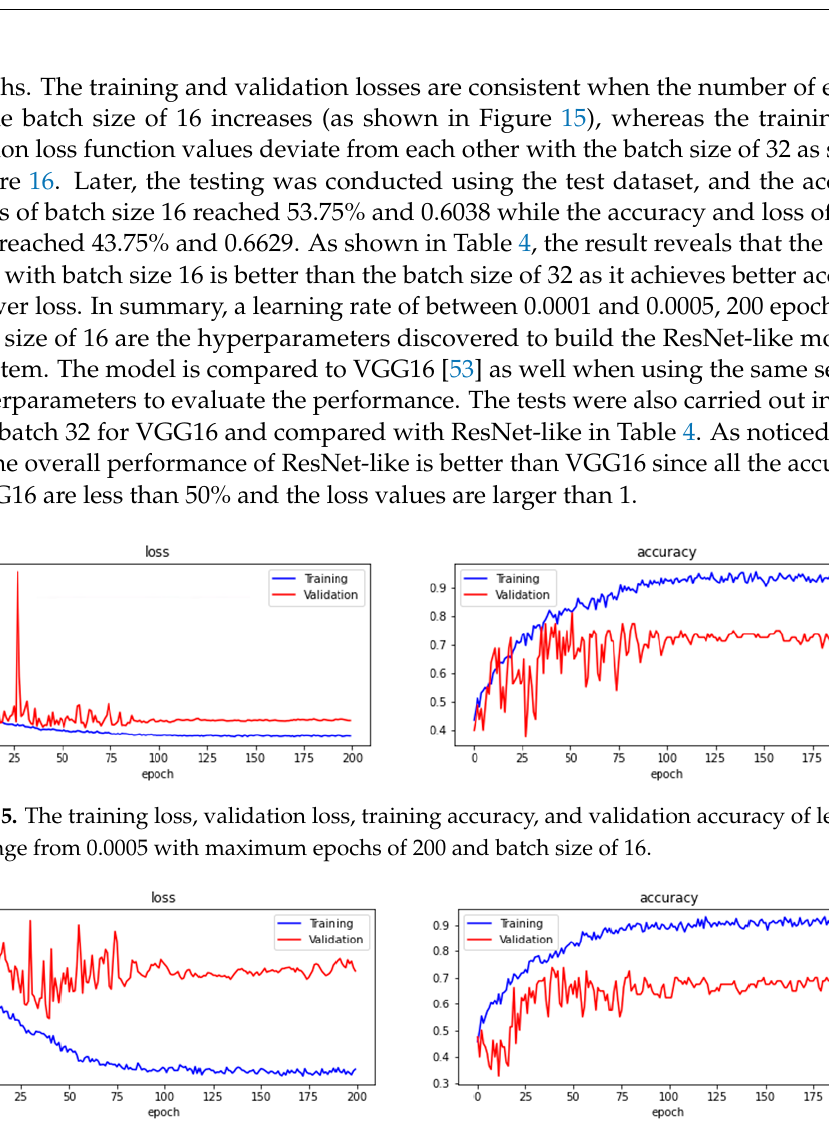
Table 4. The comparison of performances between hyperparameter batches 16 and 32. ResNet-like trained with batch size 16 is better than the batch size of 32 and it is also better than VGG16 as highlighted.